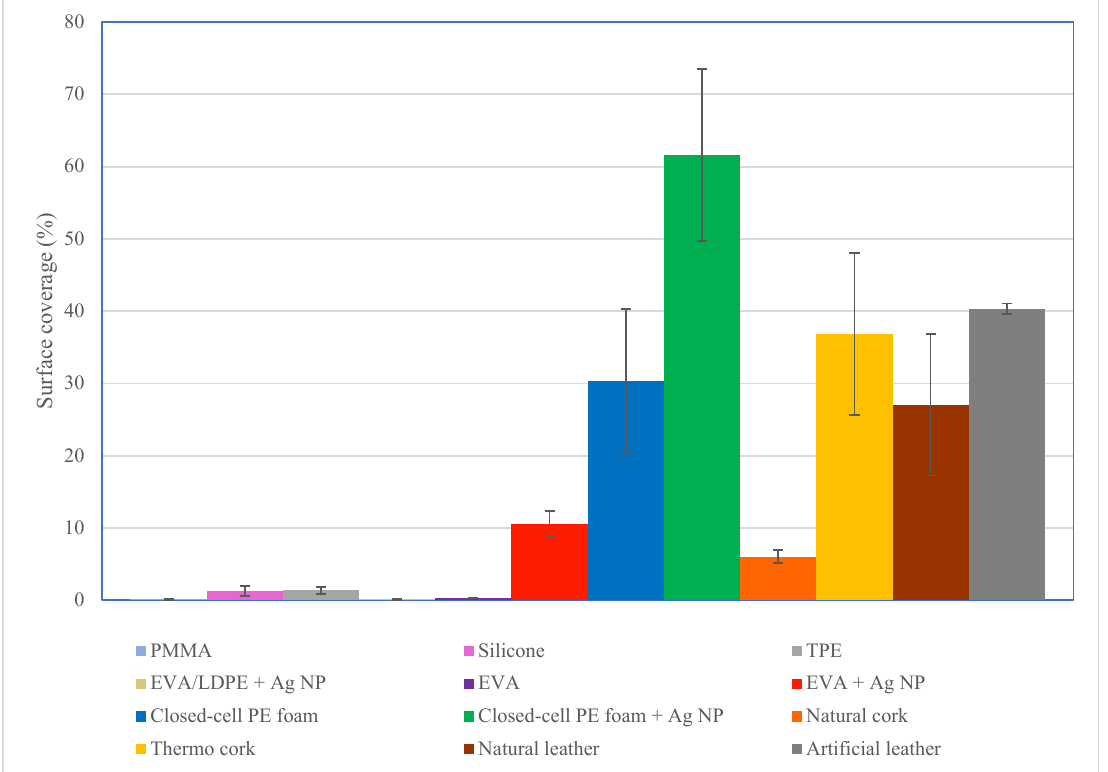
Figure 4. Growth curves of S. epidermidis ( a ) and S. aureus ( b ) in nutrient broth. For S. epidermidis , colony ‐ forming unit per milliliter (CFU/mL) as a function of time is shown, whereas, for S. aureus , the time dependence of absorbance is presented [26]. Reprinted with permission from [26]. Copyright © 2014 Elsevier.